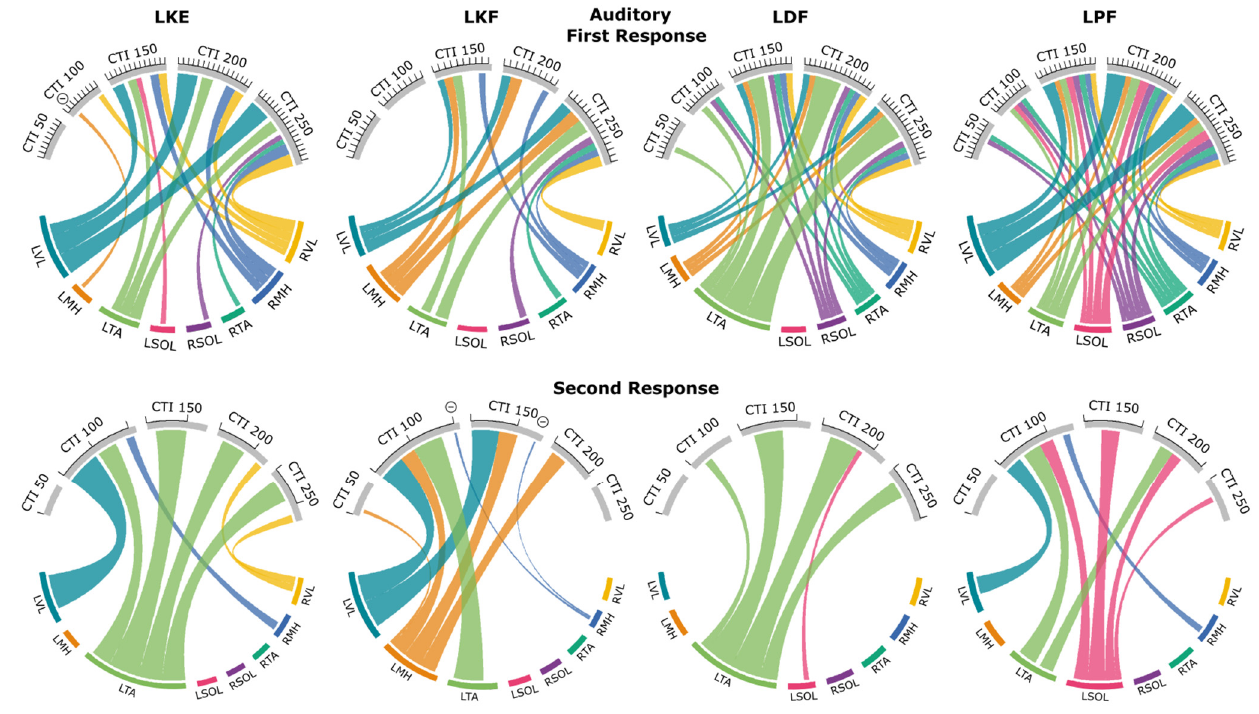
Figure 3. Excitability and inhibitory interactions during left knee extension (LKE), left knee flexion (LKF), left dorsiflexion (LDF) and left plantarflexion (LPF) movements using auditory cues: averaged significant ( p < 0.05) facilitations or inhibitions during first ( top ) or second ( bottom ) responses during auditory cues. Each first response is scaled to the control for that movement condition, where the average control response is 100% and corresponds to the distance between tick marks. Second responses are given as the ratio between the second and first response for that pair of responses. Individual muscles are grouped along the bottom of each plot. Thickness of connections denotes the amount of inhibition or facilitation found where significant inhibition is designated with a circled minus sign.